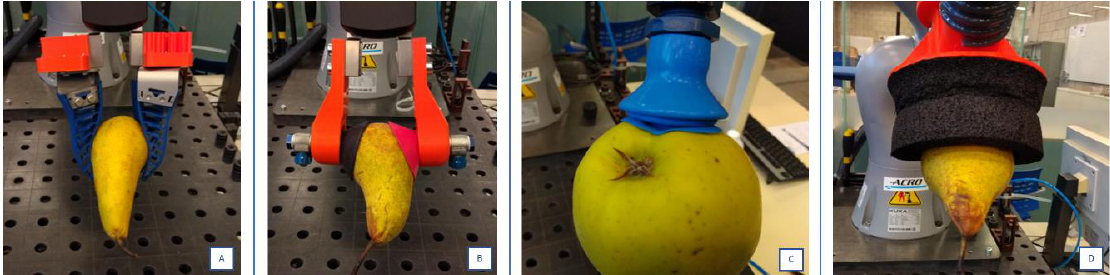
Figure 5. Overview of advantages of soft gripping principles, due to the adaptivity of: ( A ) the compliant structure of the finray fingers; ( B ) the soft cups; ( C ) the flexible sealing lip; ( D ) the compliant structure of the finray fingers; and ( D ) the adaptivity after sealing the foam gripper.